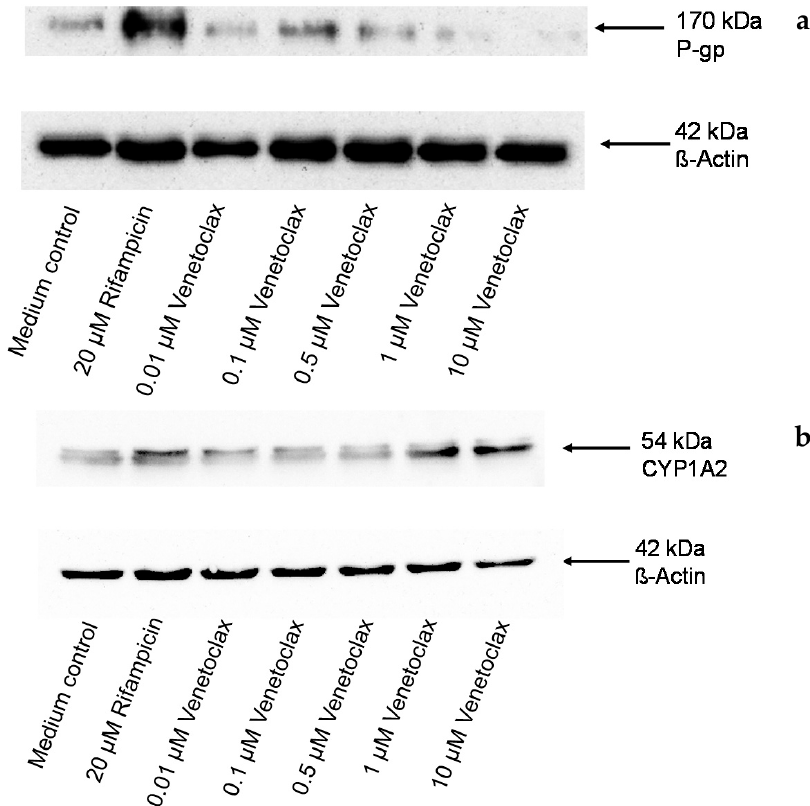
Figure 3. Western blot. Concentration-dependent effect of venetoclax (0.01–10 µM) and 20 µM of rifampicin (positive control for P-gp) after four days on P-gp ( a ) and CYP1A2 ( b ) protein expression in LS180 cells compared to untreated medium control. β -actin served as a loading control. Depicted is one blot of a series of three.